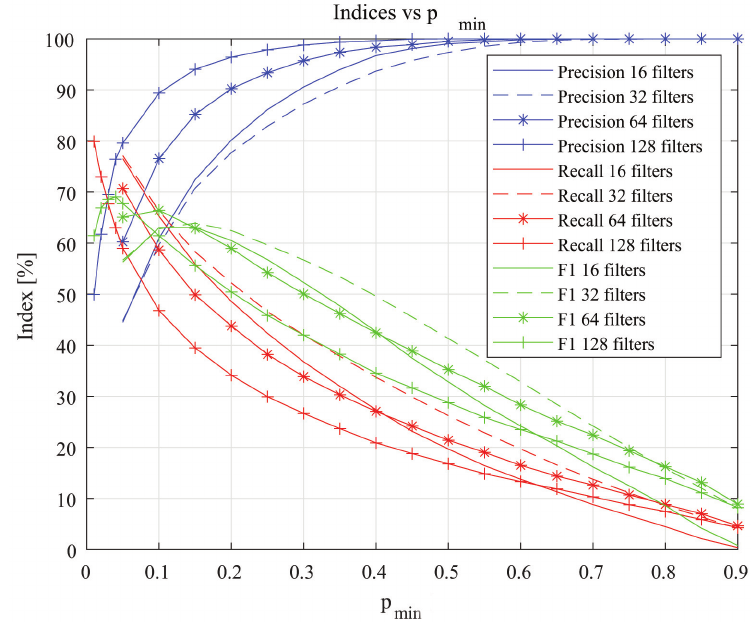
Figure 5. Performance curves vs. p min and models.